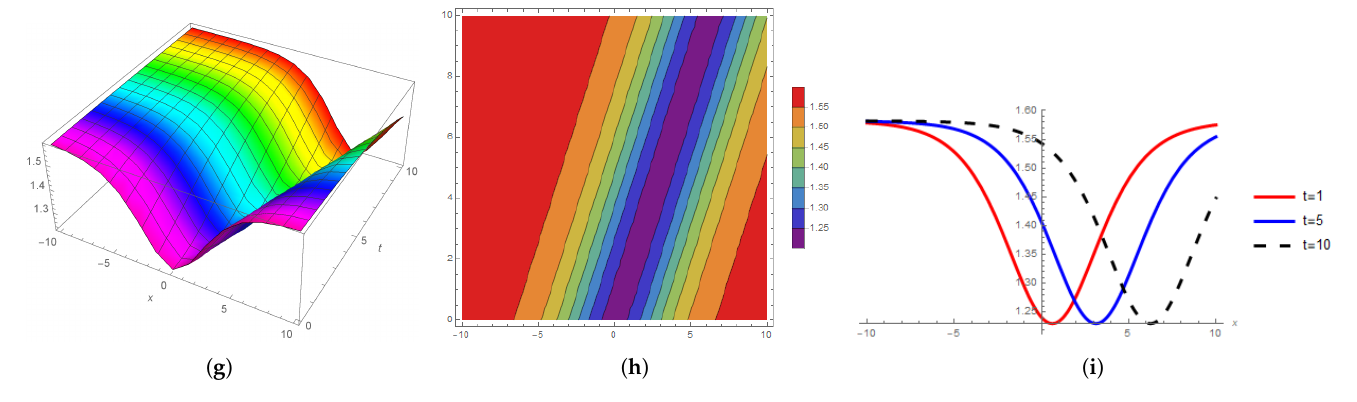
Figure 2. The 3D, contour, and 2D behavior comparison for V 1 ( ξ ) ; ( a ) 3D wave profile at soliton velocity c = 2.5; ( b ) contour wave profile at soliton velocity c = 2.5; ( c ) 2D wave profile at soliton velocity c = 2.5; ( d ) 3D wave profile at soliton velocity c = 1.5; ( e ) contour wave profile at soliton velocity c = 1.5; ( f ) 2D wave profile at soliton velocity c = 1.5; ( g ) 3D wave profile at soliton velocity c = 0.5; ( h ) contour wave profile at soliton velocity c = 0.5; ( i ) 2D wave profile at soliton velocity c = 0.5.